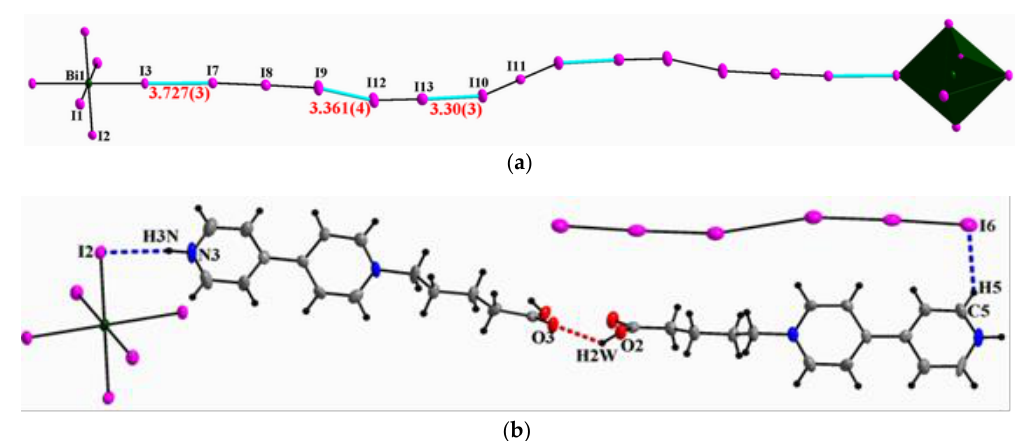
( b ) Figure 1. ( a ) The 1-D [(BiI 6 )I 13 ] n6− infinite chain constructed from the I···I contacts between (BiI 6 ) 3− ion and Z-shape I 133− Figure 1. ( a ) The 1-D [(BiI 6 )I 13 ] n6 − infinite chain constructed from the I ··· I contacts between (BiI 6 ) 3 − ion and Z-shape I 133 − polyiodide anions; ( b ) hydrogen bonds between [(BiI 6 )I 13 ] n6− chains, I 62− anions and H-BPA 2+ cations. polyiodide anions; ( b ) hydrogen bonds between [(BiI 6 )I 13 ] n6 − chains, I 62 − anions and H-BPA 2+ cations. Table 1. Selected Bond Lengths (Å) and Bond Angles ( ◦ ). Bond Dist.